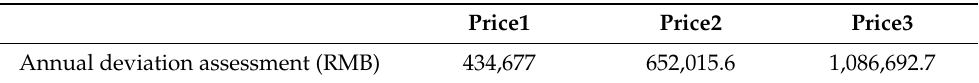
Table 6. Annual deviation assessment with three spot prices.